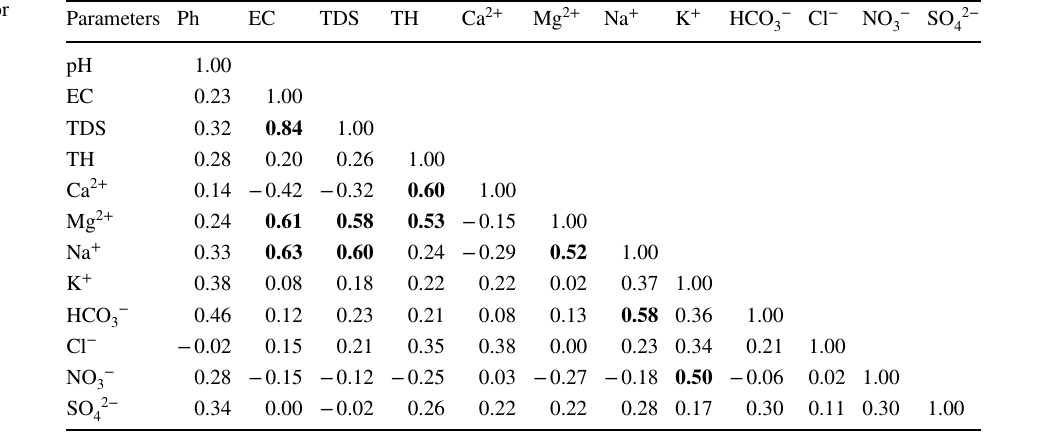
The highlighted or bold ones are those which are above 0.5 which have some correlation level and rest below 0.5 which have very low or negligible correlations are